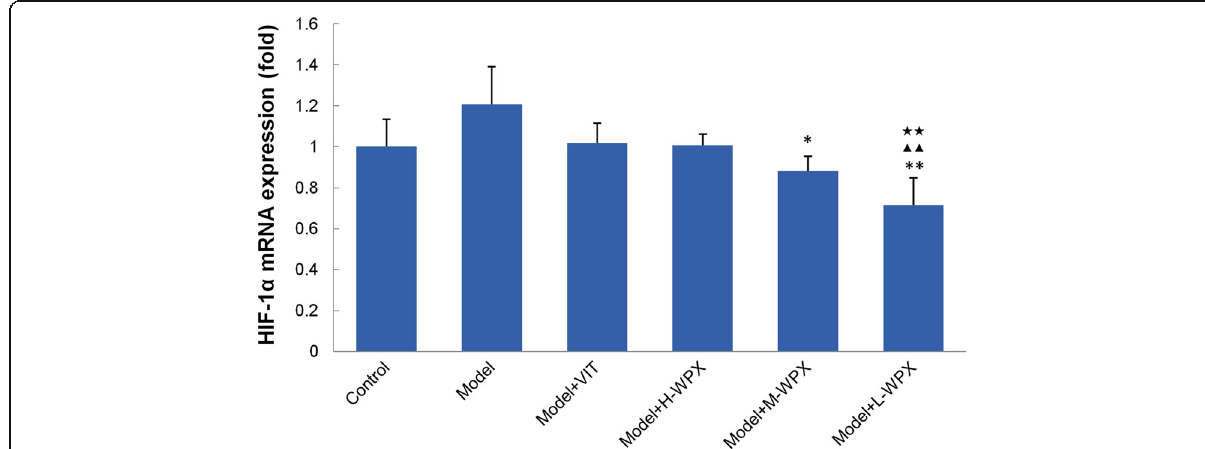
Fig. 6 Effect of WPX on HIF-1 α mRNA levels in gastric epithelial cells. The results are expressed as mean±SD ( n =9 in each group). Note: ** P <0.01, * P <0.05, vs Model; ▲▲ P <0.01, vs VIT; ★★ P <0.01, vs